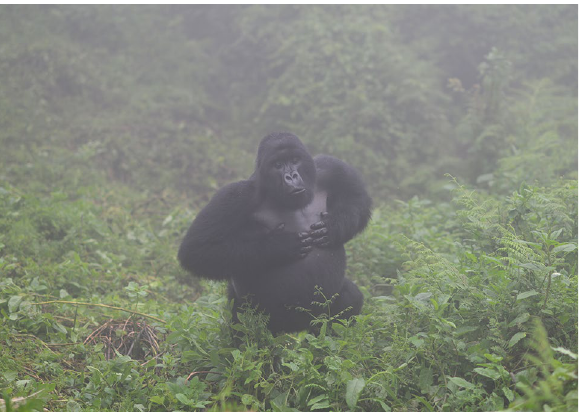
Figure 1. Mountain gorilla silverback PTO chest